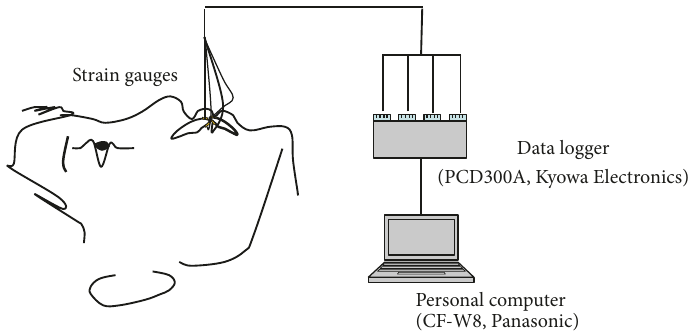
Figure 3: Schematic block diagram of the measuring strain system.